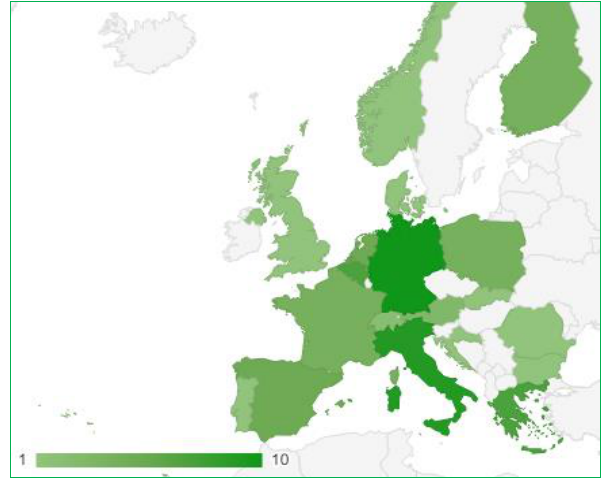
Figure 17. Geographic distribution of the total participants in the OCRE requirements gathering.